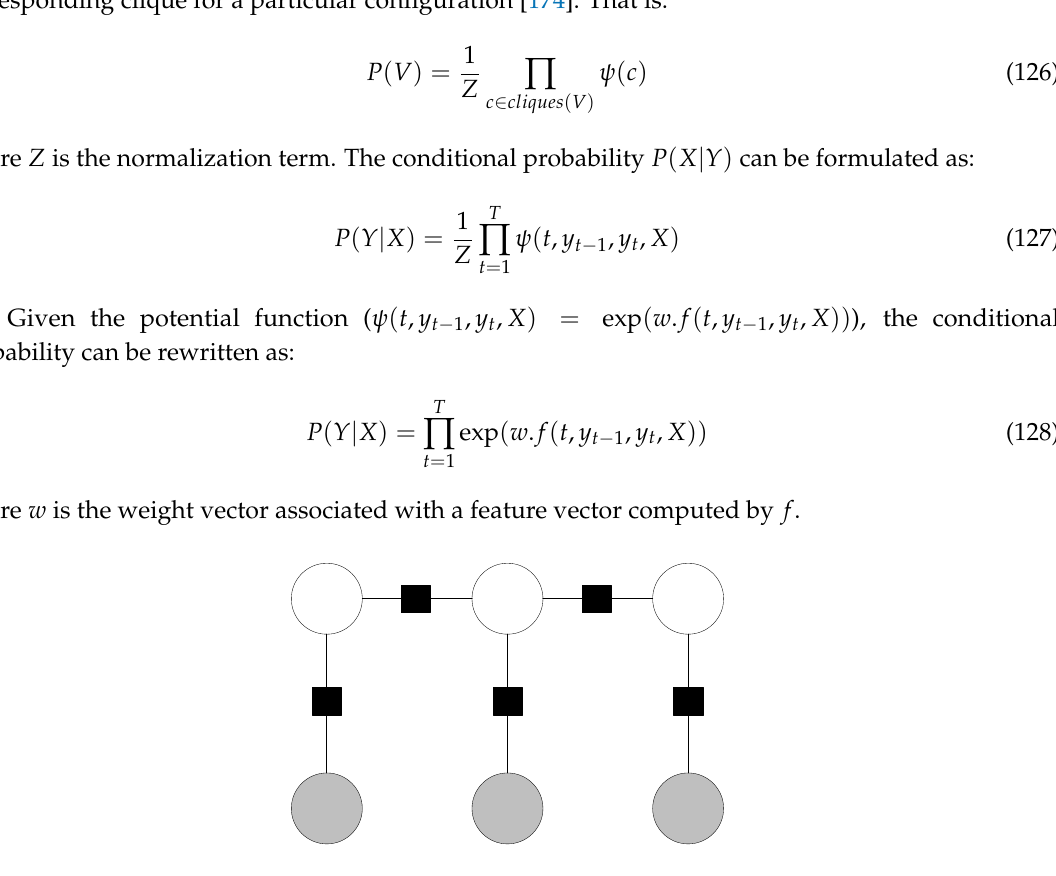
Figure 15. Linear-chain conditional random field (CRF). The black boxes are transition clique Limitation of Conditional Random Field